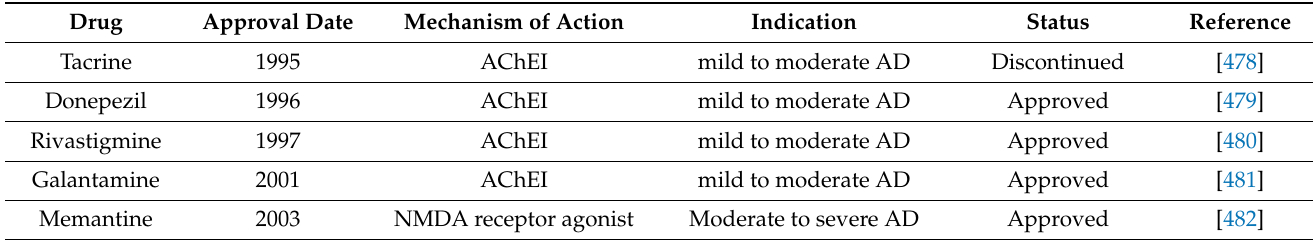
Table 10. Approved therapeutics for AD.